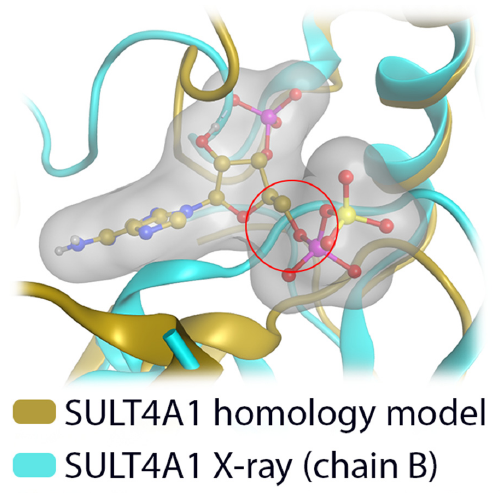
Figure 6. Comparison of our SULT4A1 homology model with the X-ray structure of SULT4A1 (PDB-id: 1ZD1 [8] , chain B). The homology model can accommodate the cofactor PAPS, while in the X-ray structure it clashes with the protein backbone (red circle).